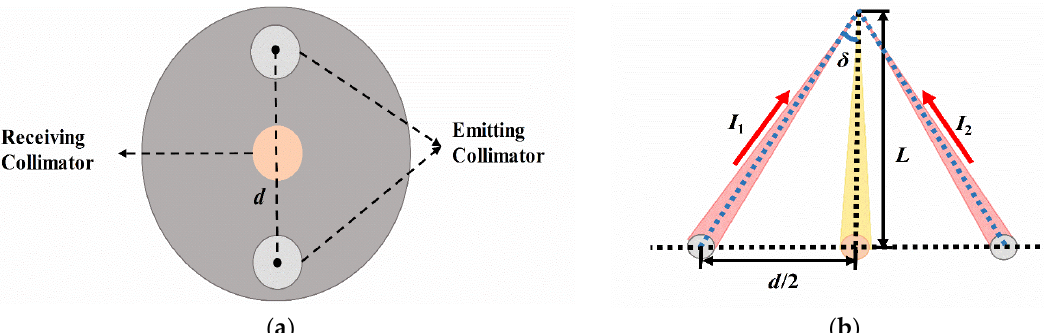
Figure 2. Schematic diagram of: ( a ) Integrated optic probe; ( b ) Light paths in the measurement space.